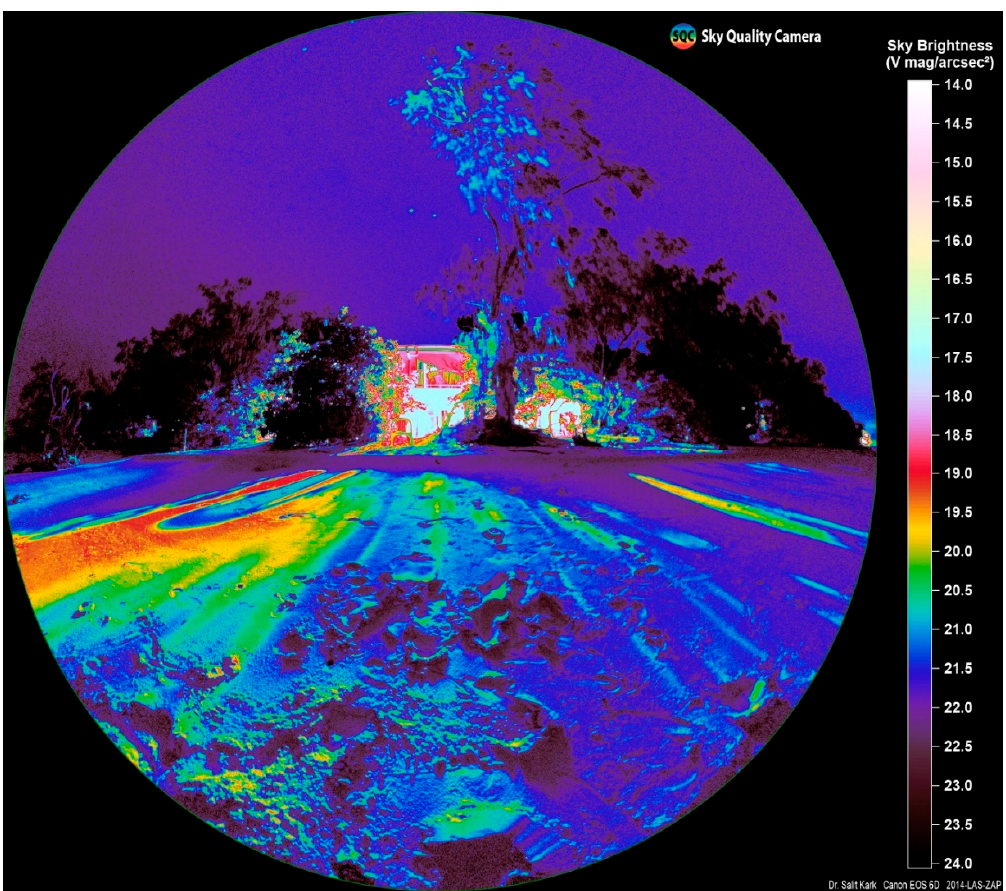
Figure 5. Sky Quality Camera calibrated and analysed horizontal landward facing photograph taken on the night of 17 June 2018 at sampling site 5 (facing the resort) Heron Island, Australia (refer to Figure 6b for the raw image).